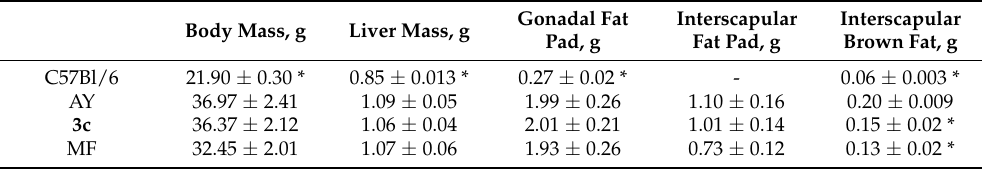
Table 3. Mass of livers, gonadal fat pads, interscapular fat pads, and brown fat in AY mice treated for four weeks by compound 3c at a dose of 15 mg/kg and MF at a dose of 250 mg/kg. * p < 0.05 as compared to AY mice.